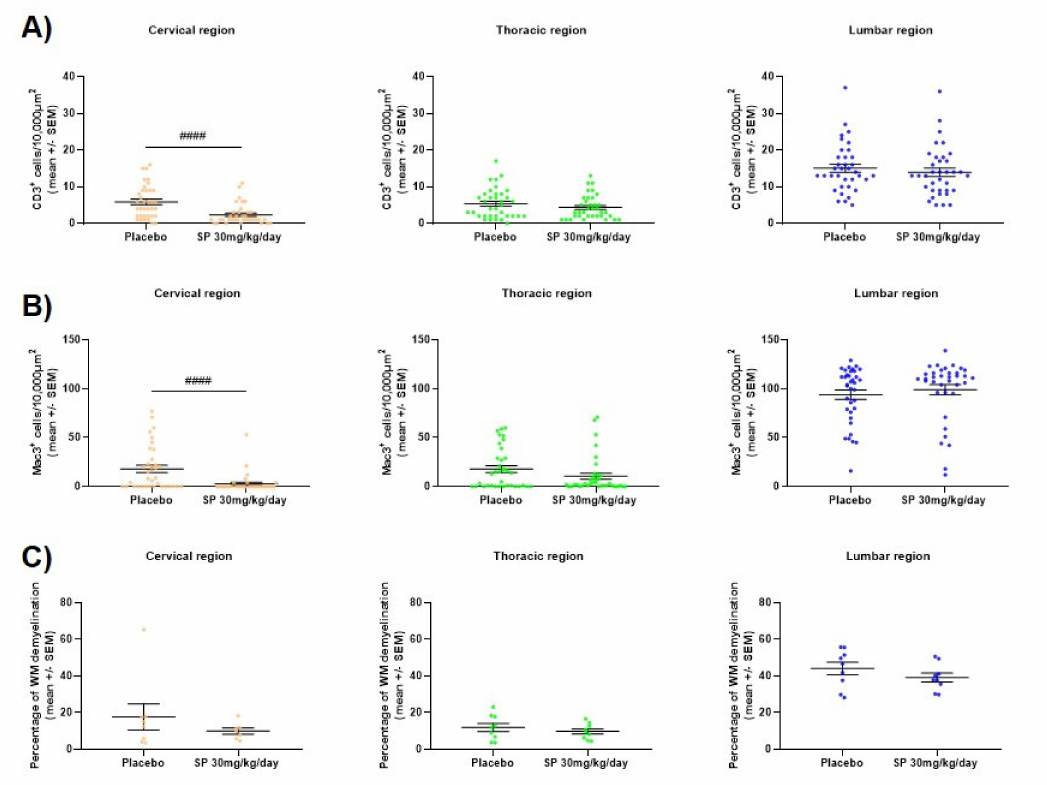
Figure A5. E ff ect of SP treatment on murine spinal cord ( A ) CD3 + cell infiltration, ( B ) Mac3 + cell infiltration and ( C ) demyelination. Spinal cords were extracted from control or SP 30 mg / kg / day-treated EAE-diseased mice (acute phase). Three segments of each spinal cord (cervical, thoracic and lumbar) were evaluated. For each segment, four di ff erent regions of interest were analyzed except for demyelination where the complete white matter was analyzed. Control ( n = 9), SP 30 mg / kg / day ( n = 9) and 3 days of treatment. ( A – B ) immunohistochemistry and (C) luxol fast blue staining. Each dot represents a measurement. Abbreviations: SC: spinal cord, SEM: standard error of the mean, SP: SP600125 and WM: White matter. Statistic: Mann–Whitney test, #### <